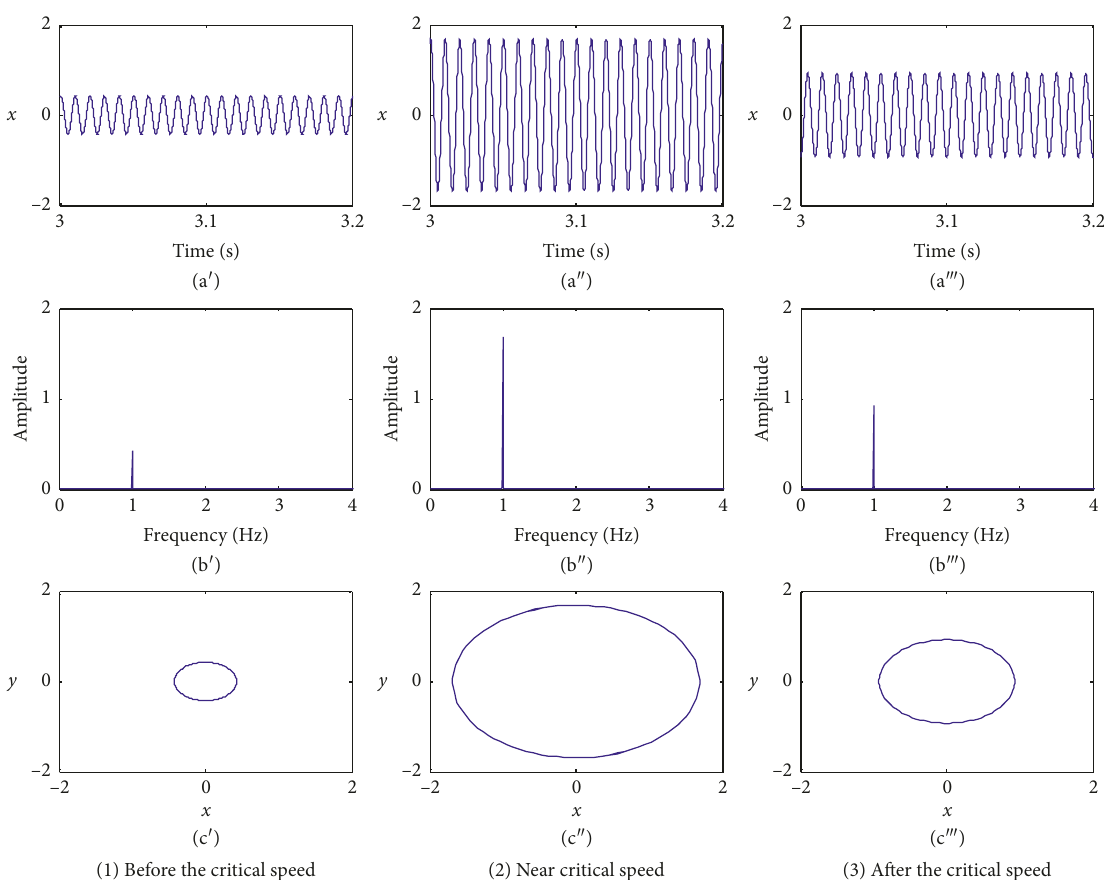
Figure 2: Dynamic response of the speed change to the